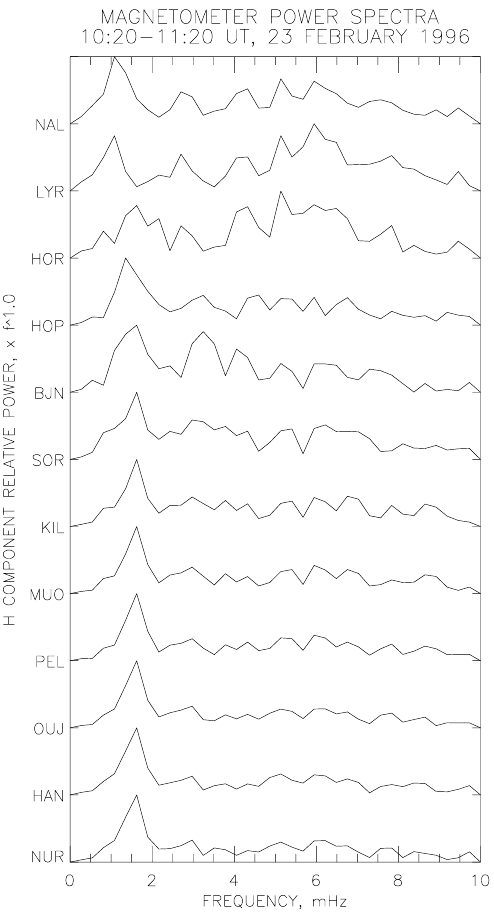
Fig. 6c. Power spectra for 10:20–11:20UT (resolution is 0.3mHz). Spectra were weighted by f 1 . 0 and